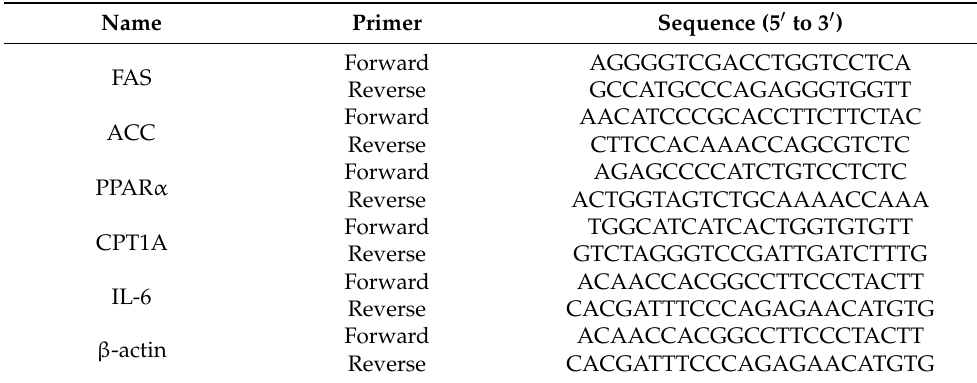
Table 1. Sequences of primers (mouse) used in